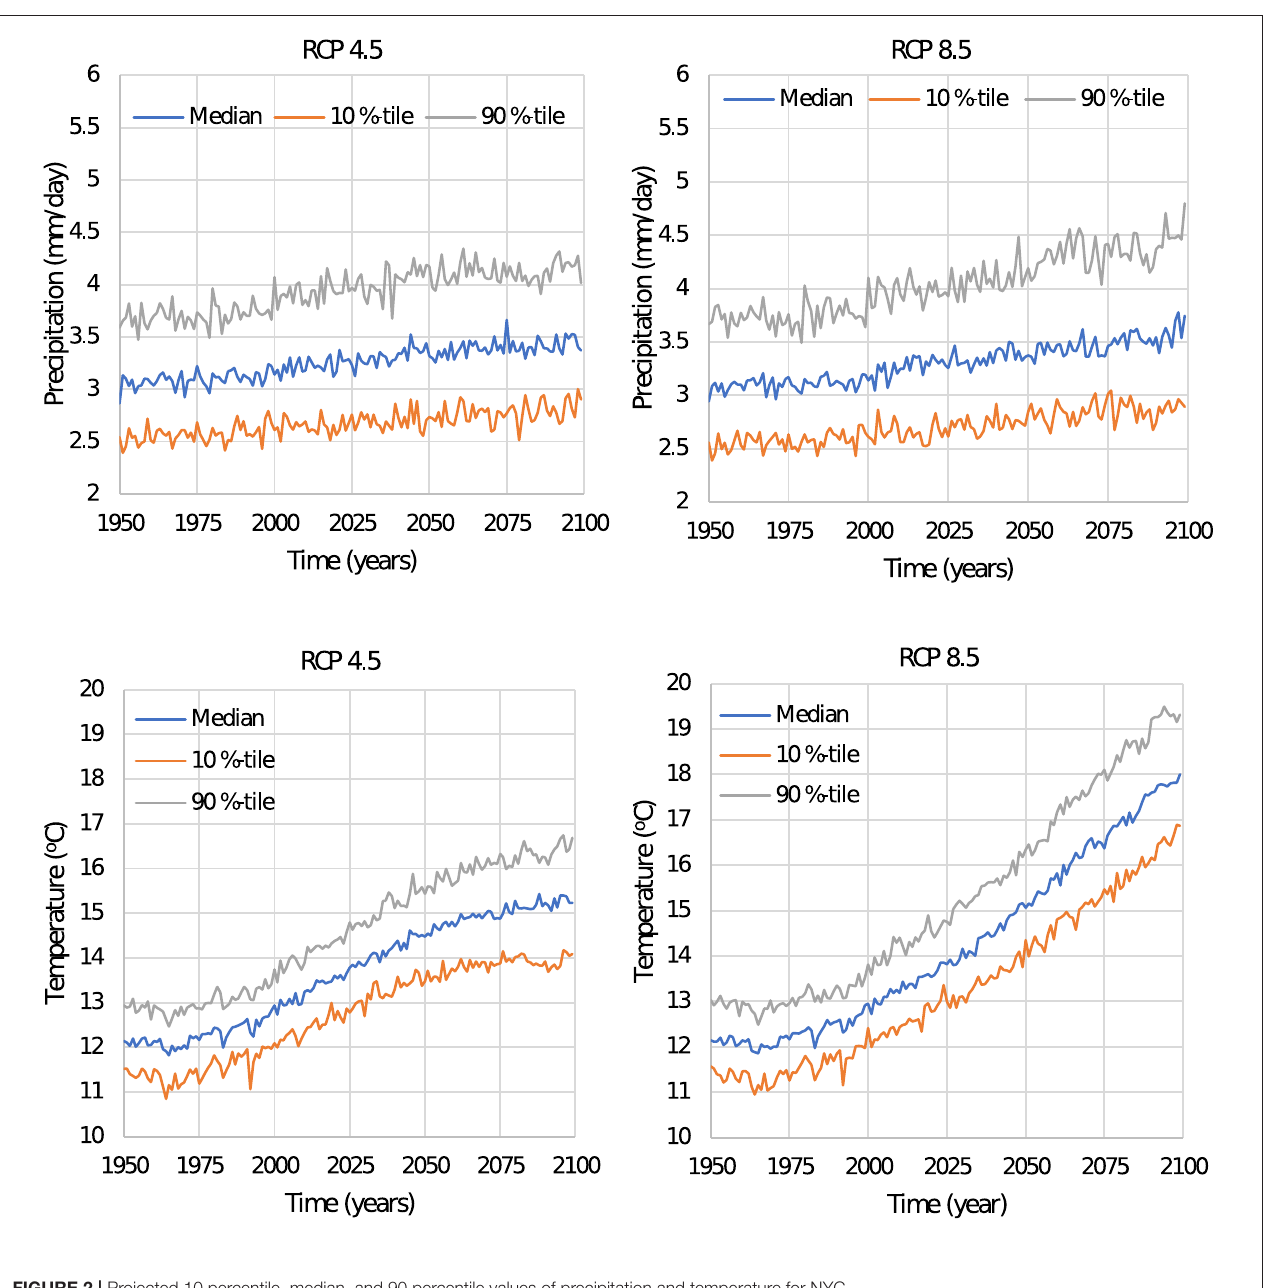
FIGURE 2 | Projected 10 percentile, median, and 90 percentile values of precipitation and temperature for